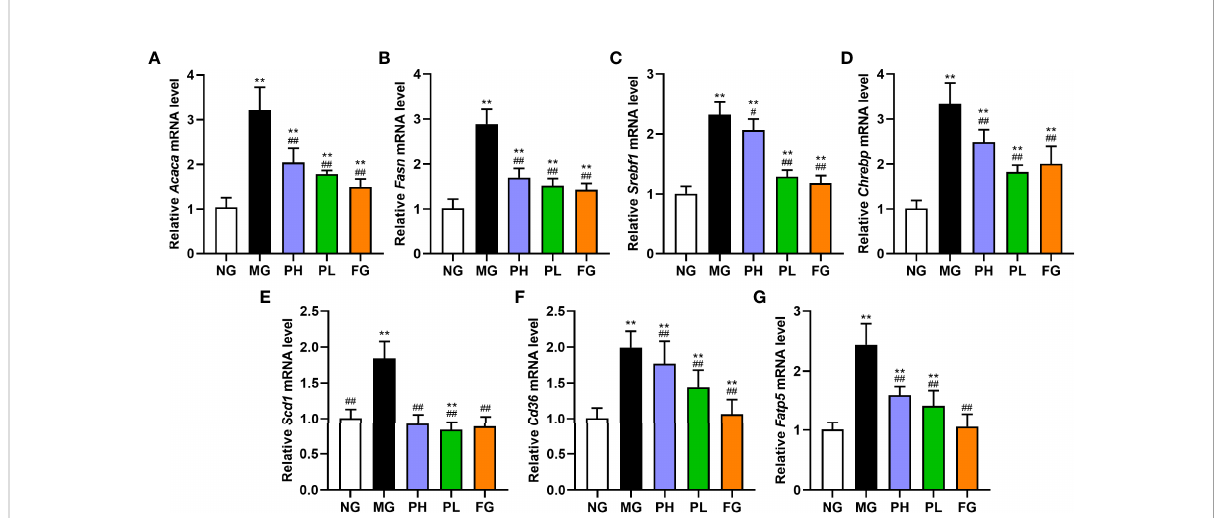
FIGURE 7 Effect of puerarin on expression of lipid synthesis-related genes in hepatic. (A) Acaca ; (B) Fasn ; (C) Srebf1 ; (D) Chrebp ; (E) Scd1 ; (F) Cd36 ; (G) Fatp5 . Data were expressed as mean ± SD (n = 10). **p < 0.01, vs . NG; # p < 0.05, ## p < 0.01, vs . MG.